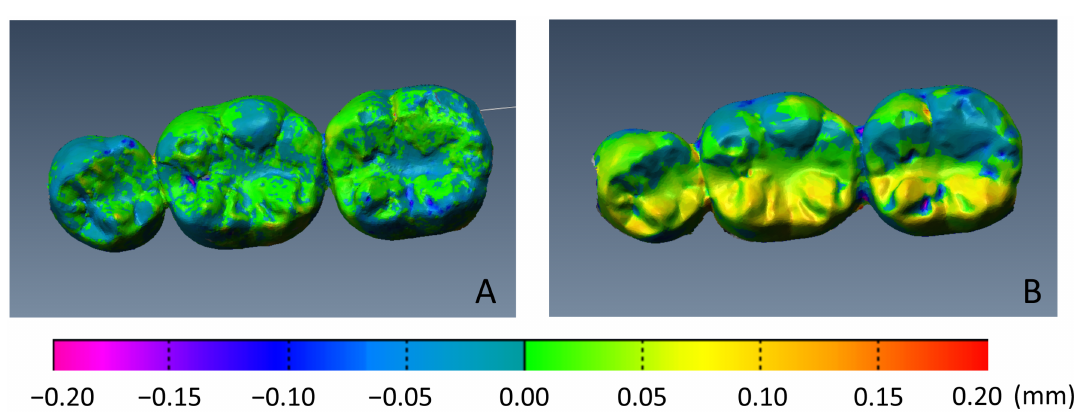
Fig 2. Color mapping for each measurement point (Participant a). A. Digital impression technique.B. Conventional impressiontechnique. Visual inspectionof the color mappingdata demonstrated a smaller discrepancy (green and blue) betweenrepeatedmeasurements by the two operators for the digital impressiontechniquethan for the conventional impressiontechnique(yellowand red).